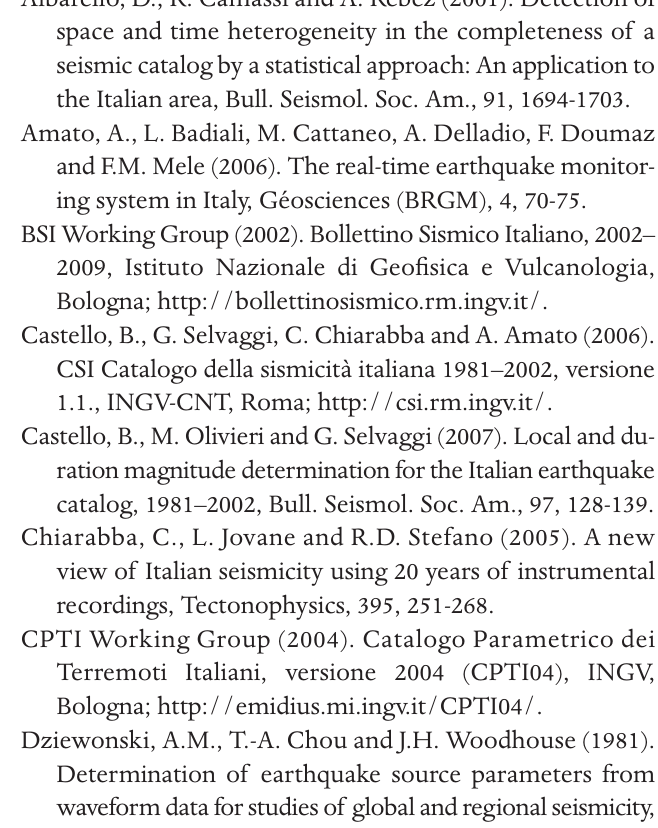
Figure 6. (Left) Comparison of magnitudes for 153 identical events in the CSI 1.1 and CPTI08 for M in the CSI 1.1. The red circe show M compared to M L magnitude difference between CPTI08 and the CSI 1.1 shifts when the magnitude transformation is